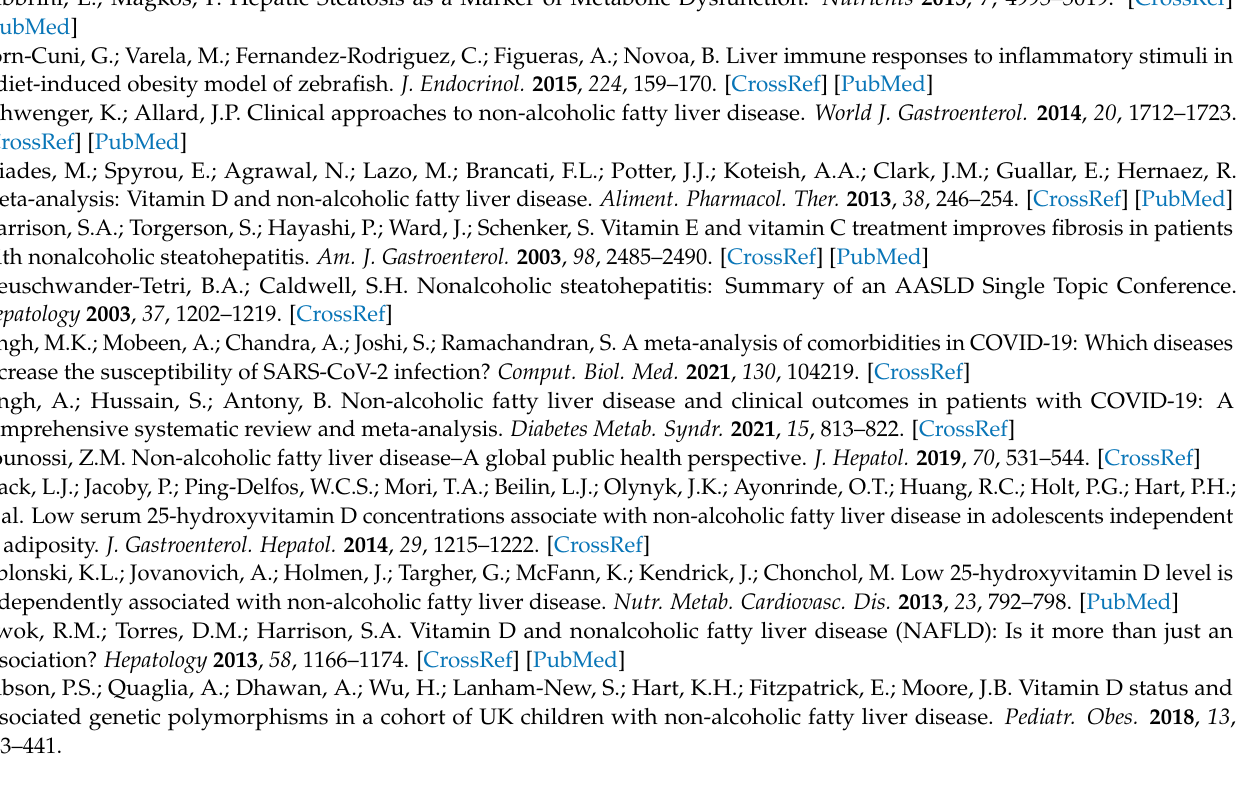
various Zebrafish NAFLD models; Figure S2: BMI and fat levels in adult NAFLD zebrafish liver after feeding; Figure S3: Relative expression levels of cyp24a1 in zebrafish liver as measured by RT- qPCR, and Figure S4: Metascape pathway analysis of top differentially expressed genes of NAFLD Zebrafish following high VitD diet compared to NAFLD untreated control. Table S1: Differentially and significantly expressed genes following transcriptomic analysis of NAFLD treated with high VitD compared to NAFLD untreated control; Table S2: Differentially expressed genes by RNA- sequencing, and Table S3: Top pathways differentially expressed in NAFLD supplemented with high VitD compared to non-VitD supplemented